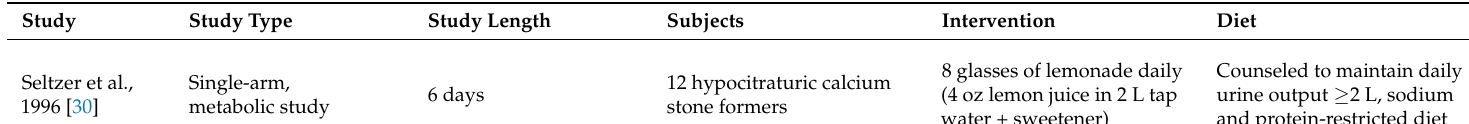
Table 1. Summary of studies on the impact of lemon juice and lemonade on urinary